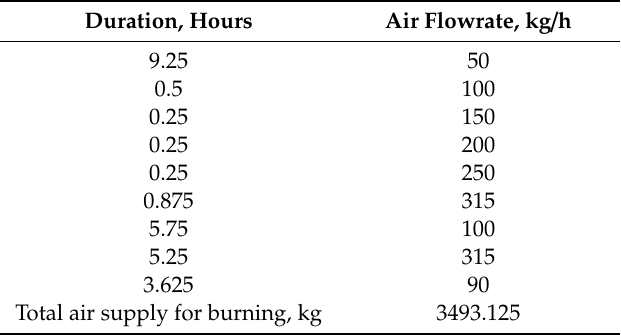
Table 1. Air flowrate change for coke